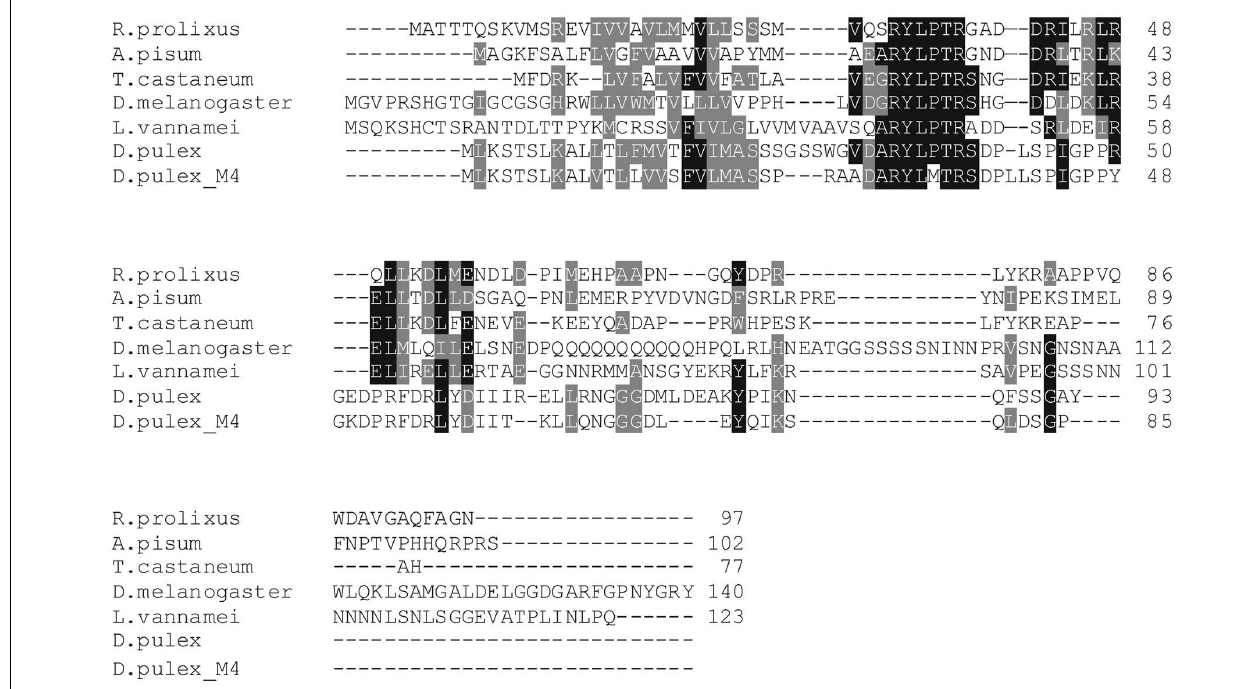
(EFX88050) were aligned with ClustalW. Following a 60% majority rule, identical amino acids are highlighted in black and similar amino acids are highlighted in gray.